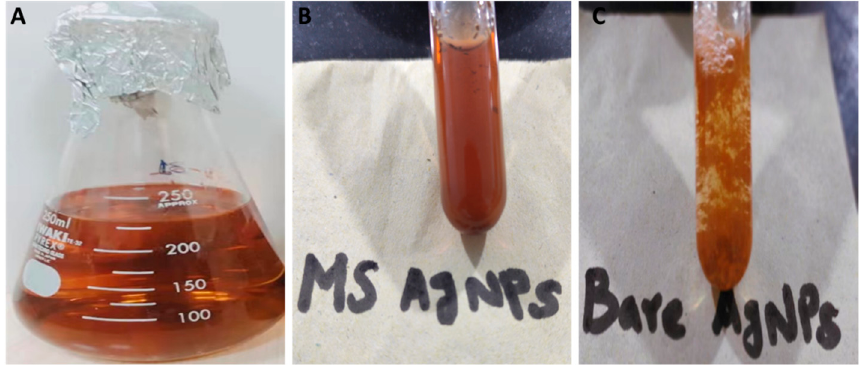
Figure 1. Visual appearance of MS-AgNPs and bare AgNPs; ( A ) fungal filtrate, ( B ) MS-AgNPs, and ( C ) bare AgNPs. ( C ) bare